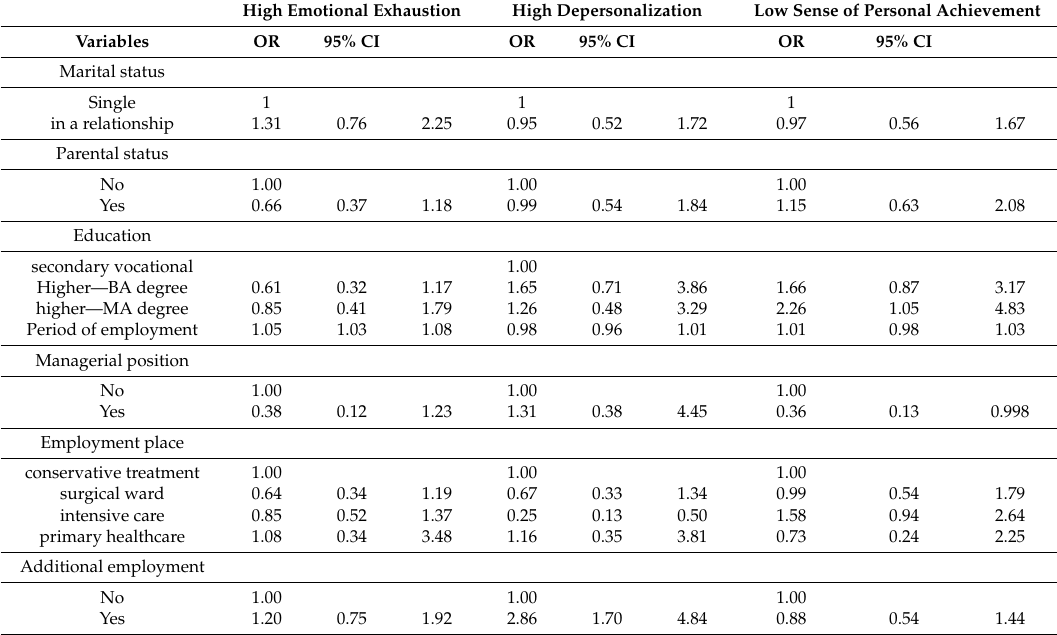
Multidimensional relation between selected socio-demographic factors and work characteristics, and high emotional exhaustion and depersonalization accompanied by low sense of personal achievement. High Emotional Exhaustion High Depersonalization Low Sense of Personal